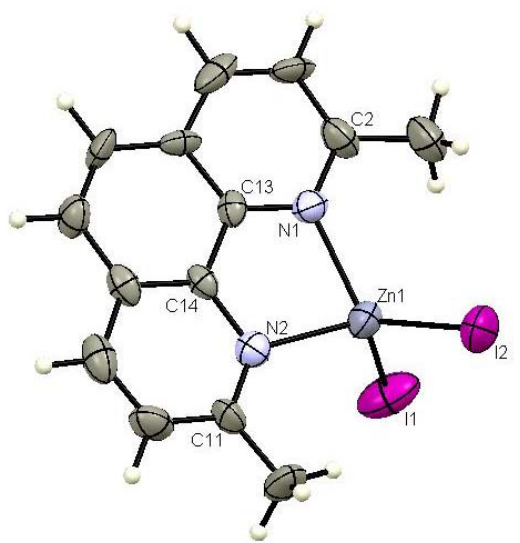
Fig. 4. Coordination environment of the [Zn(dmph)I